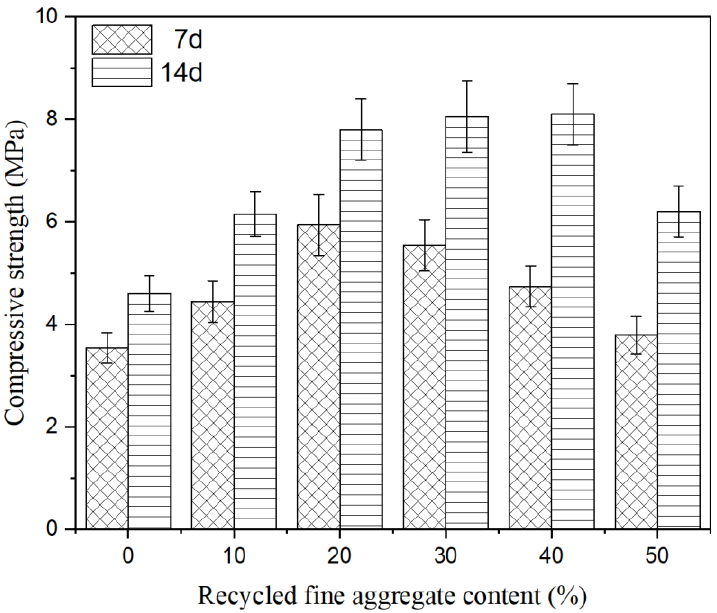
Figure 3. Compressive strength of soft soil solidified by composite solidification